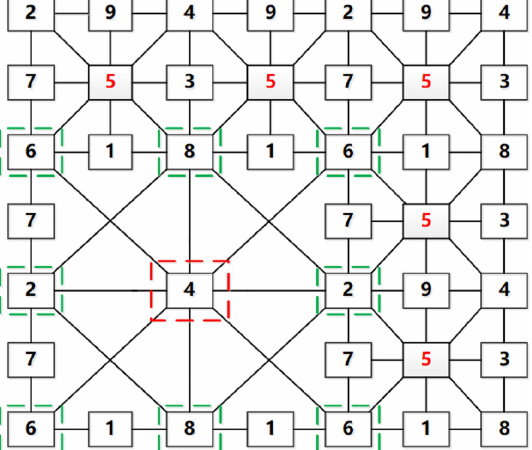
Figure 24. Regenerated topological structure diagram of 7 × 7 nested magic squares